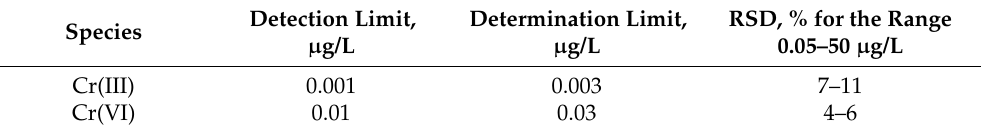
Table 5. Analytical figures of merit determined after five parallel determinations.